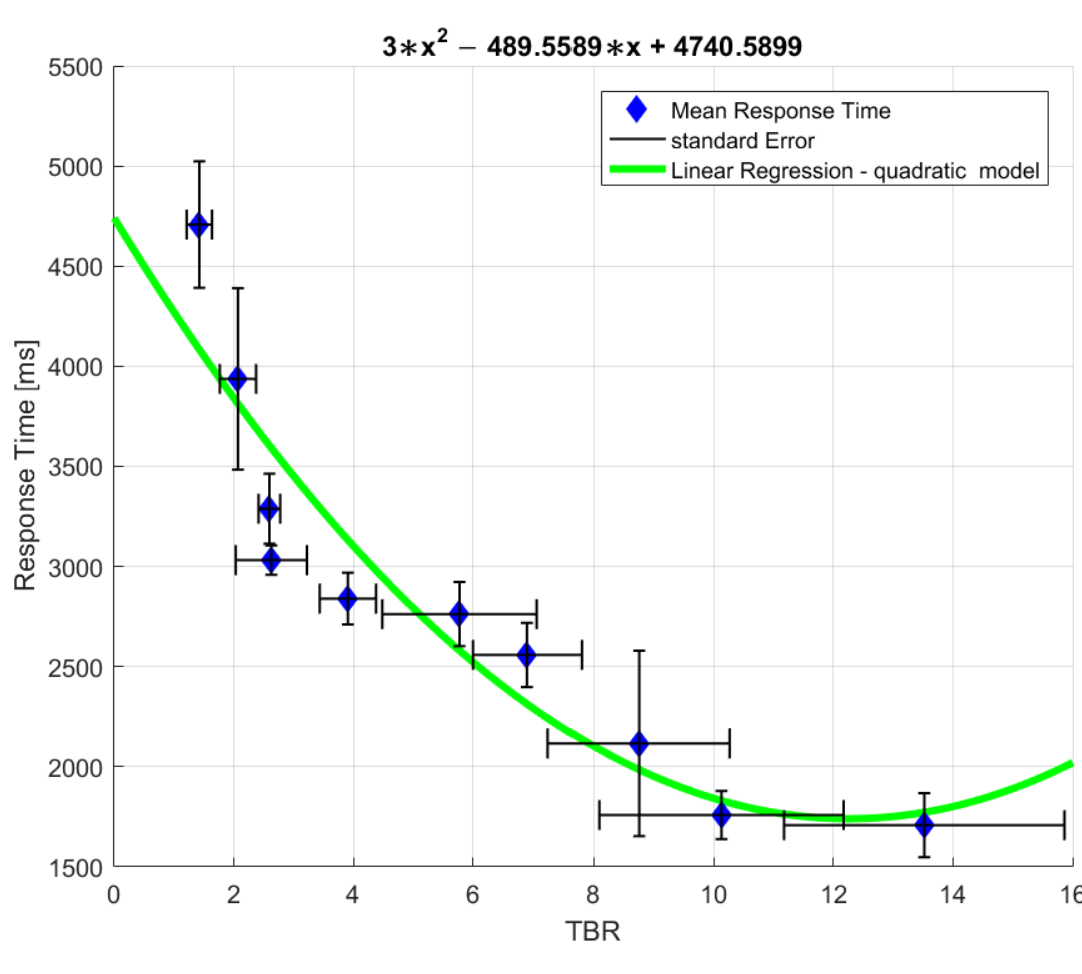
Figure 1. CI effect on TBR—regression model—channel F4.